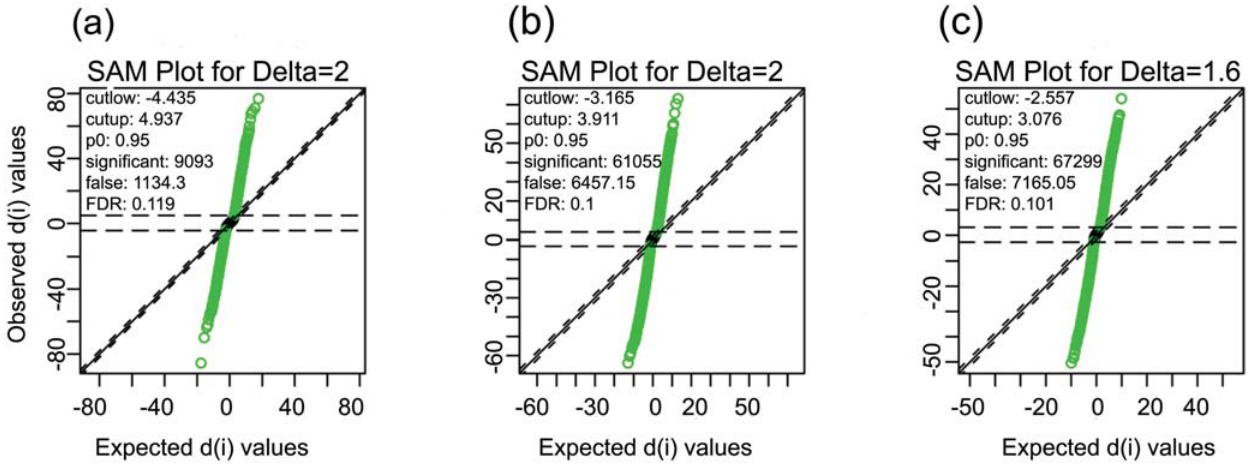
Figure 3. SAM plot of normalized data for CP&LG (a) and CP&RT (b) and LG&RT(c) pairs. Observed d-statistics (y-axis) is plotted against the expected d-statistics (x-axis) as determined by permutations and SFPs exceeding the threshold are shown in green. The sign ( + / 2 ) with SFPs indicates direction of polymorphism. In (a) the (-) sign (i.e. CP-SFP) indicates polymorphism in LG (i.e. CP . LG) and ( + ) sign (i.e. LG-SFP) polymorphism in CP (i.e. LG . CP); in (b) the (-) sign (i.e. CP-SFP) signifies polymorphism in RT(i.e. CP . RT) and the ( + ) sign (i.e. RT-SFP) polymorphism in CP(i.e. RT . CP) and in (c) the (-) sign (i.e. LG-SFP) indicates polymorphism in RT (i.e. LG . RT) and ( + ) sign (i.e. RT-SFP) polymorphism in LG (i.e. RT . LG). CP=Cypress, LG=LaGrue and